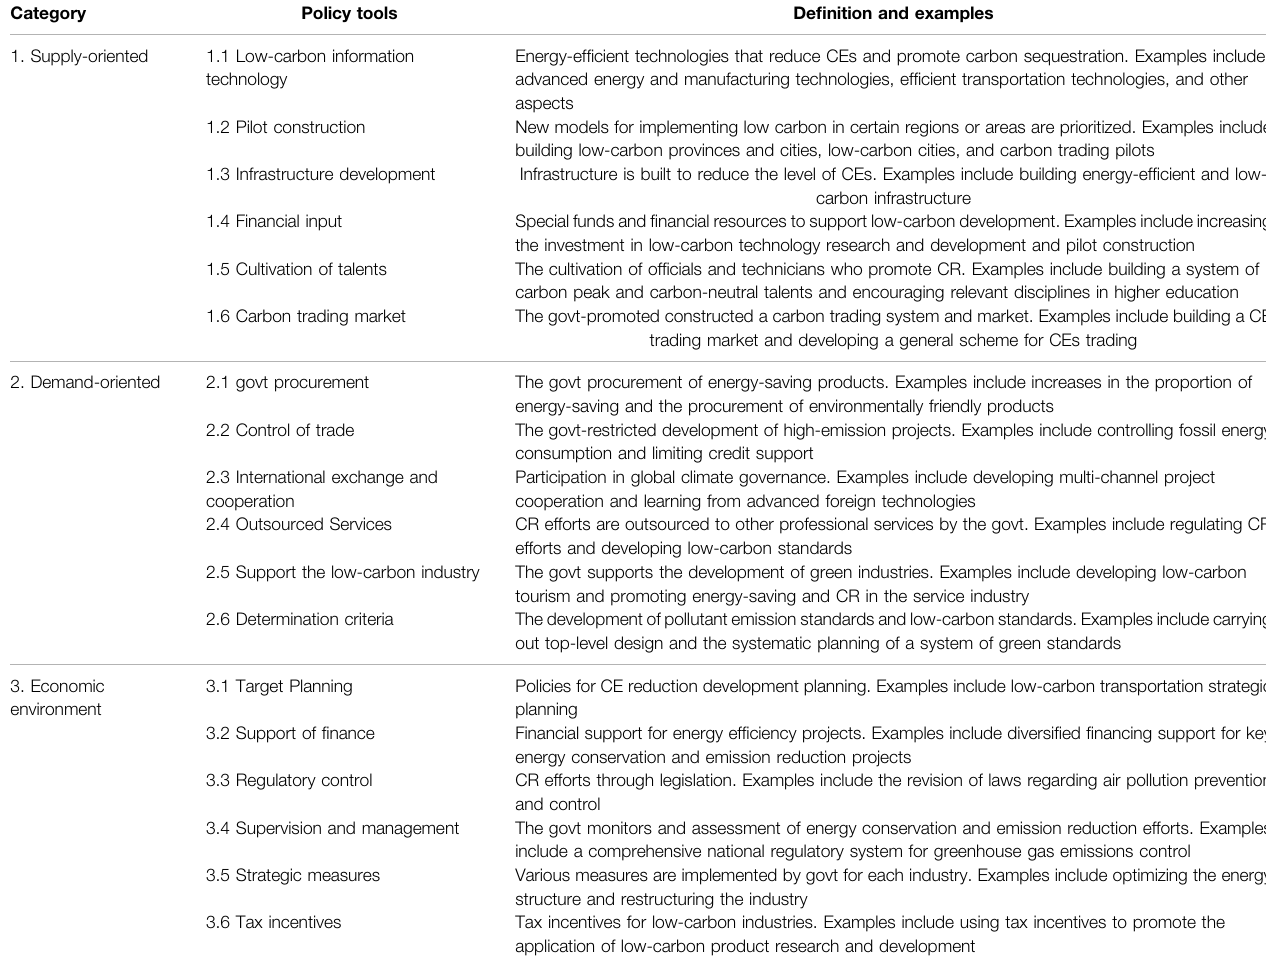
TABLE 1 | Categories of CR policy